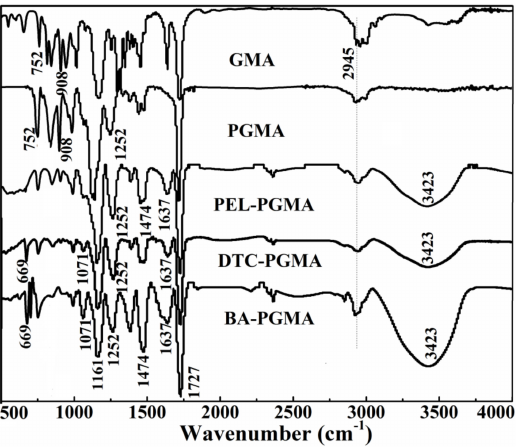
Figure 1. Fourier transform infrared spectroscopy (FT-IR) spectra of GMA, PGMA, PEL-PGMA, DTC-PGMA and